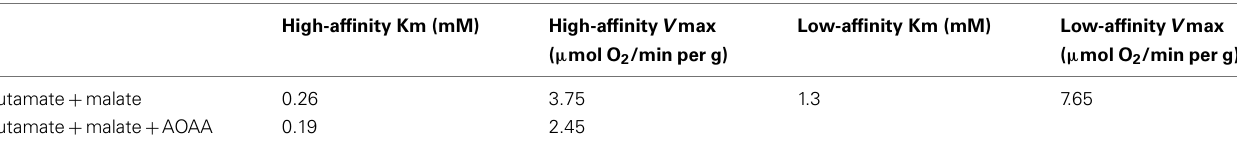
Table 2 | Oxygen consumption rates as indications of kinetics of glutamate-dehydrogenase and aspartate–glutamate transferase activities in non-synaptic mitochondria from the